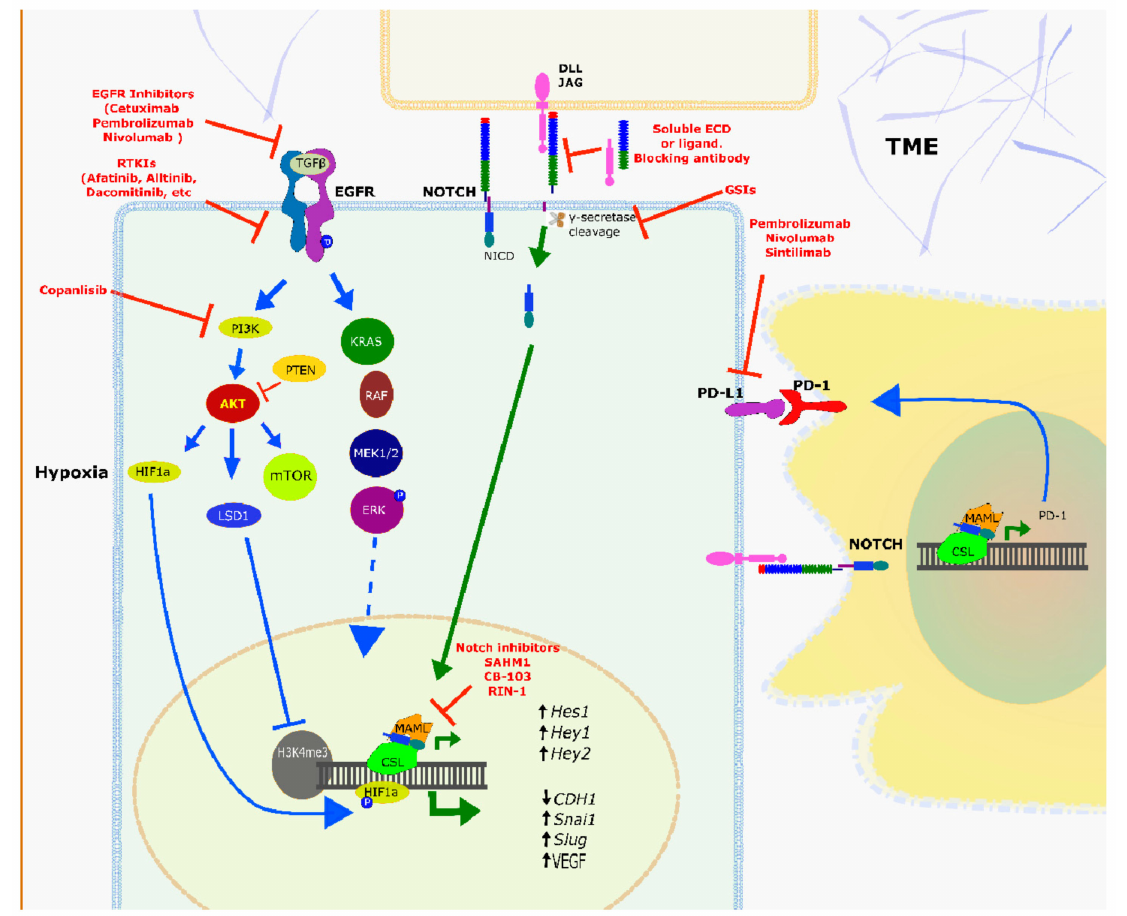
Figure 6. Schematic summary of pathways, and targeted drugs, as described in chapter 2, with a special focus on mechanisms that involve Notch